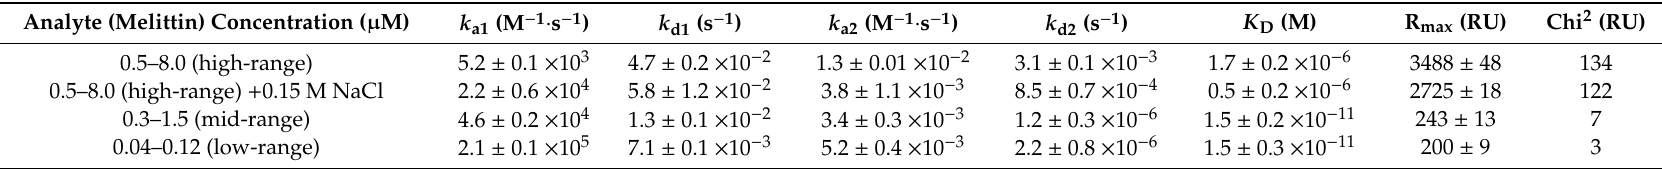
Table 2. Kinetic and data-fitting parameters for melittin–POPC interactions based on a two-state reaction model. Data were measured at the three concentration ranges and obtained from fitting sensorgrams to a two-state reaction model to obtain estimates of association ( k a1 and k a2 ) and dissociation rates ( k d1 and k d2 ) as well as binding constants ( K D ), R max and Chi2 values. Uncertainties are given as mean ± SEM obtained from the curve